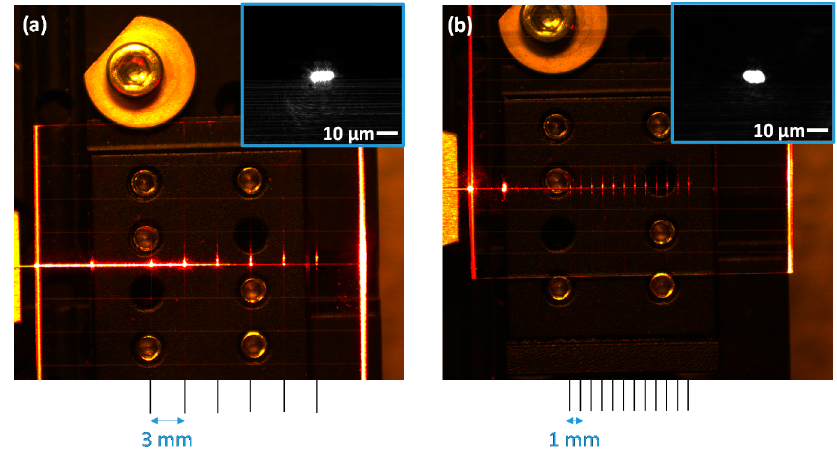
Figure 17. Top-view of TiO 2 –SiO 2 waveguide grid after signal injection at 638 nm for ( a ) 6 perpen- dicular waveguides spaced by 3 mm and ( b ) 12 perpendicular waveguides spaced by 1 mm. In both cases, the corresponding inset illustrates the guided mode at 638 nm, and the waveguides are surrounded by air.